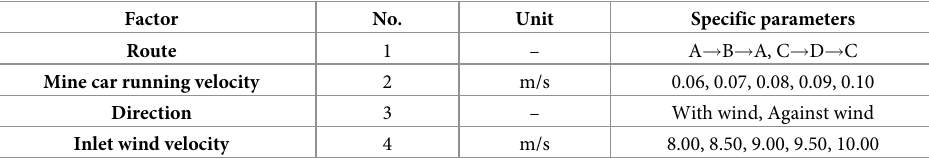
Table 1. Mine-car operation experimental